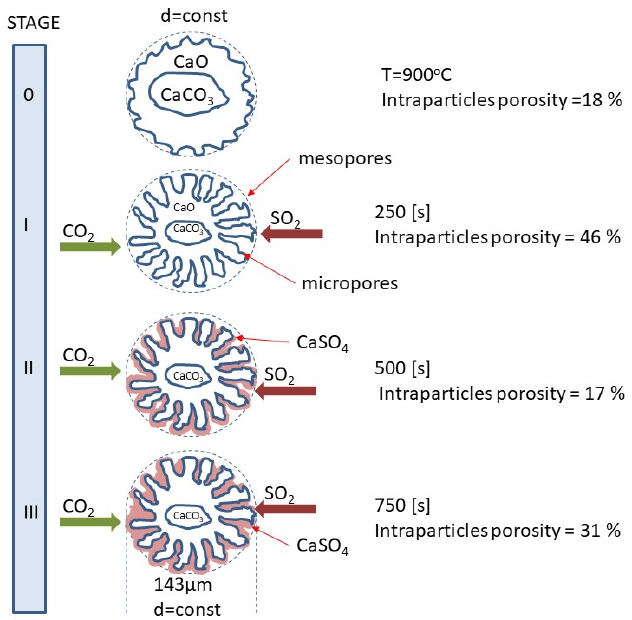
Figure 11. Evolution of porosity changes in the sorbent grain during simultaneous calcination and sulfation under oxy-fuel combustion. sulfation under oxy-fuel